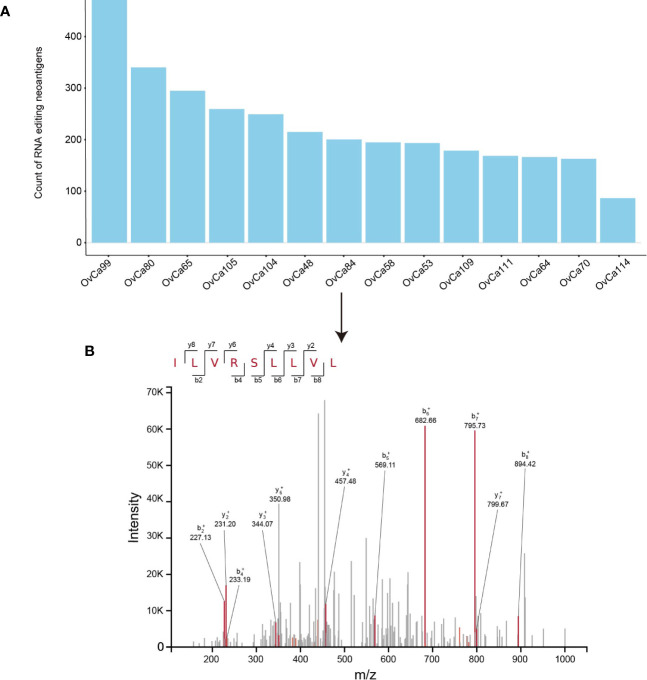
Validation of RE neoantigen in ovarian tumor cohort. (A) RE neoantigen identified by PREP in 14 ovarian tumor sample. (B) RE neoantigen identified in the OvCa84 tumor sample originating from gene OSBPL9 was predicted by PREP and validated by mass spectrometry in the immunopeptidome.